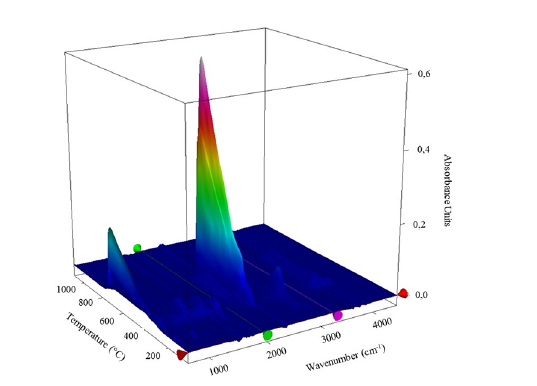
Figure 4. Infrared gas spectrum resulting from the thermal analysis of the epoxy resin.